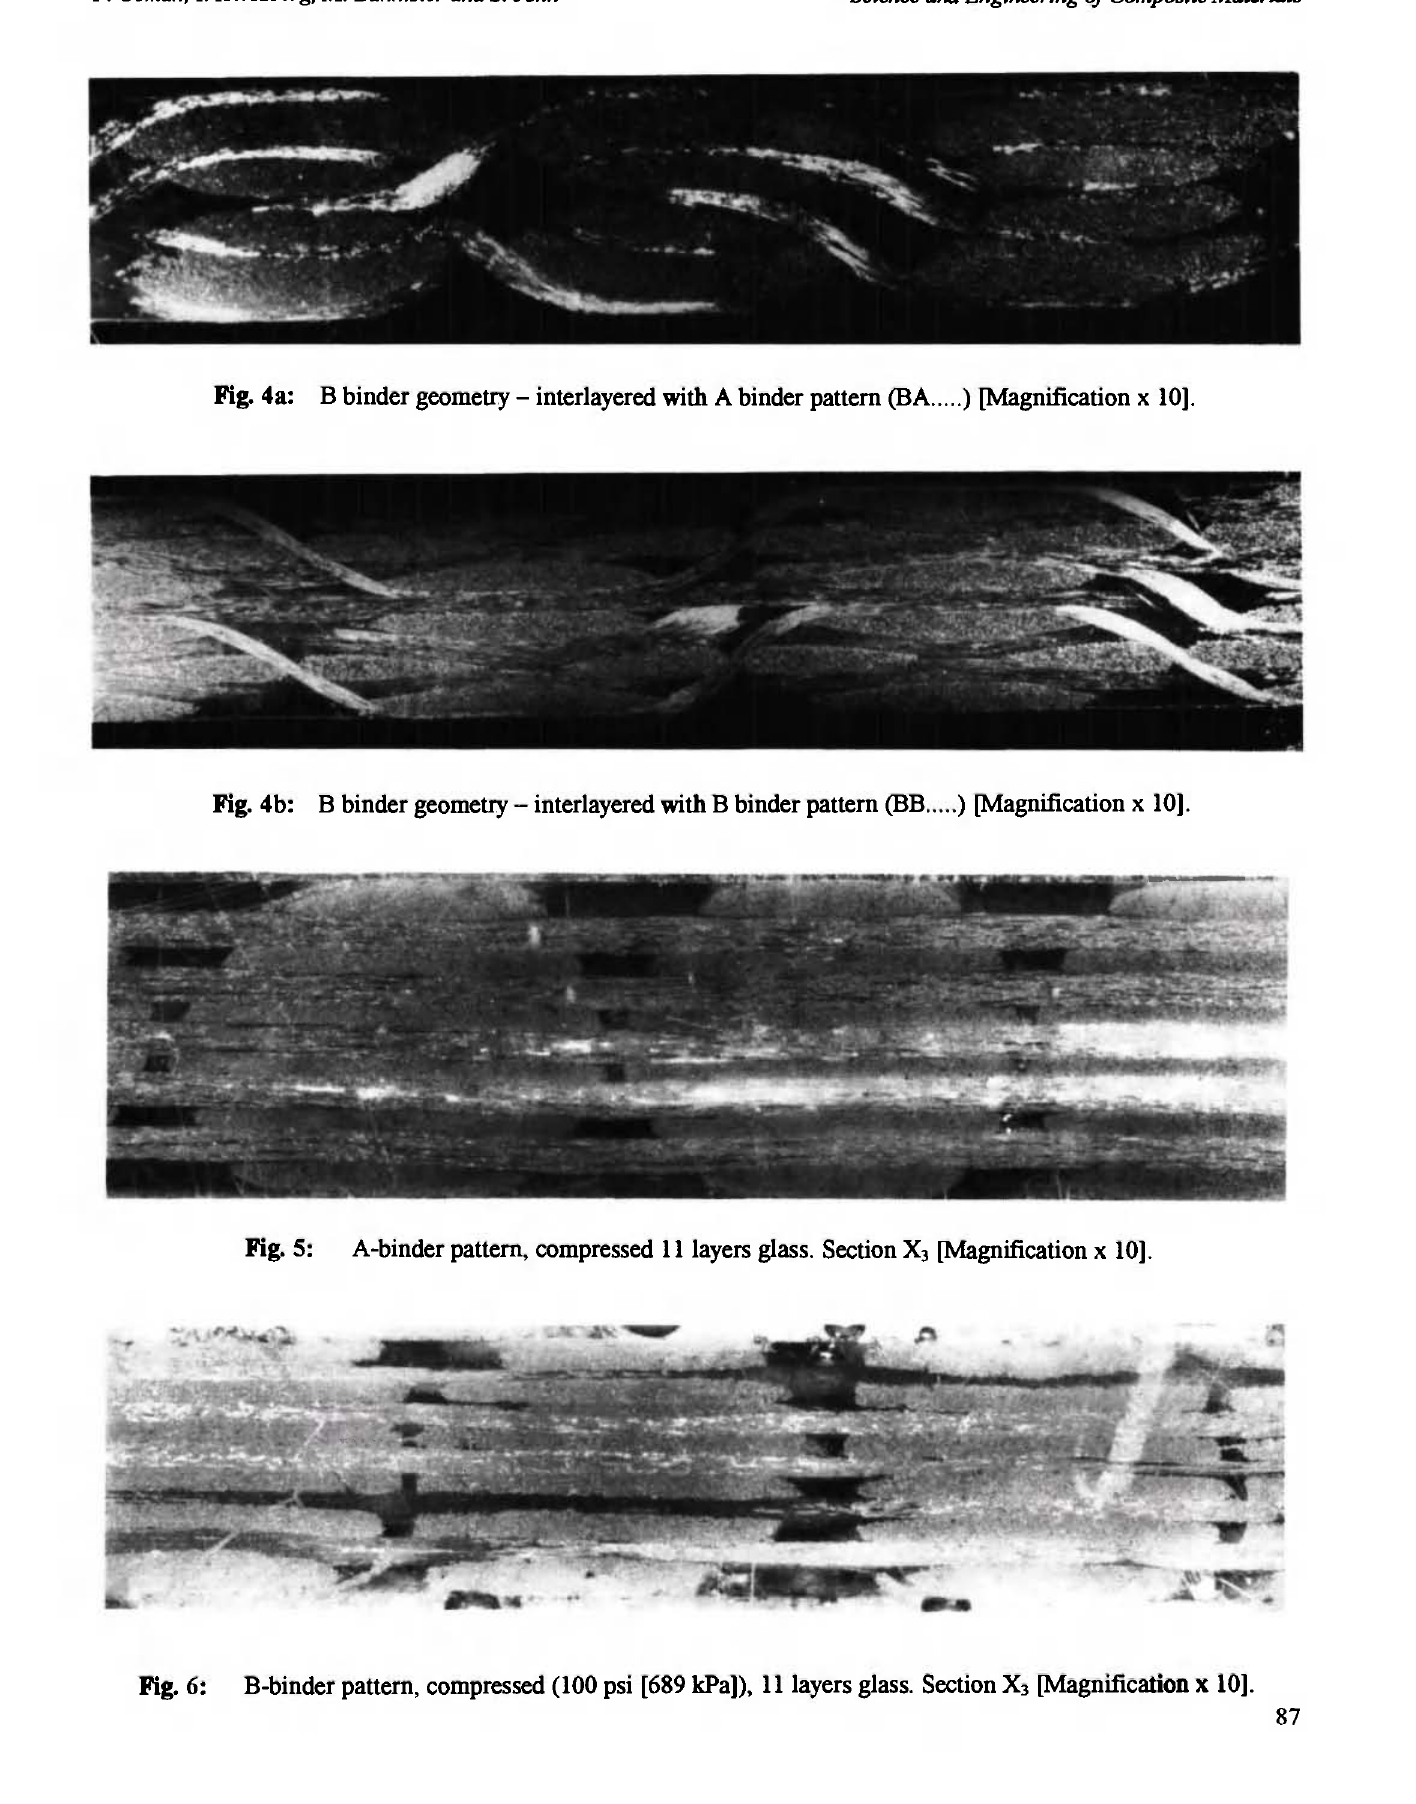
[Magnification χ 10], 3